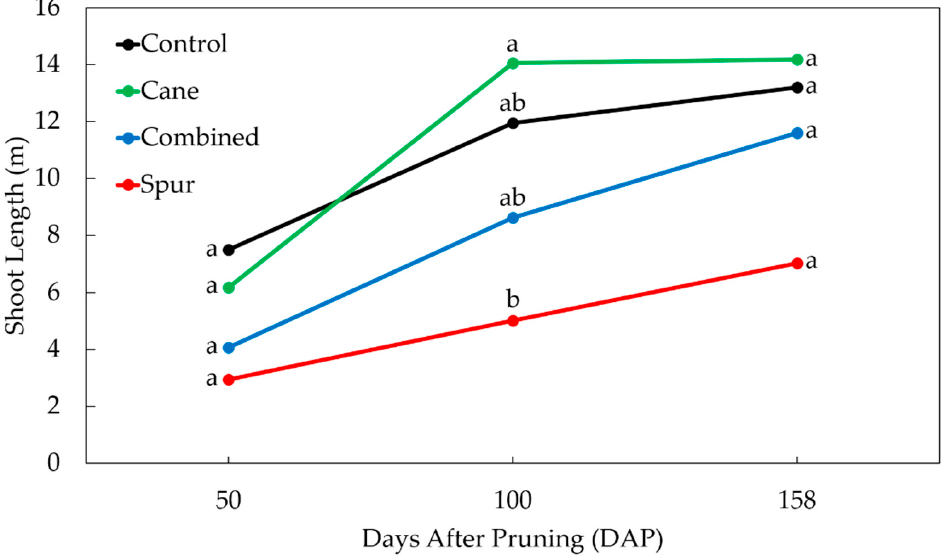
Figure 4. Changes along the season in total new growth as a result of the number and length of new shoots in response to different pruning treatments. Mean comparison for dates after pruning carried out by Tukey’s test at p < 0.05. For each date, different letters indicate statistical significance.